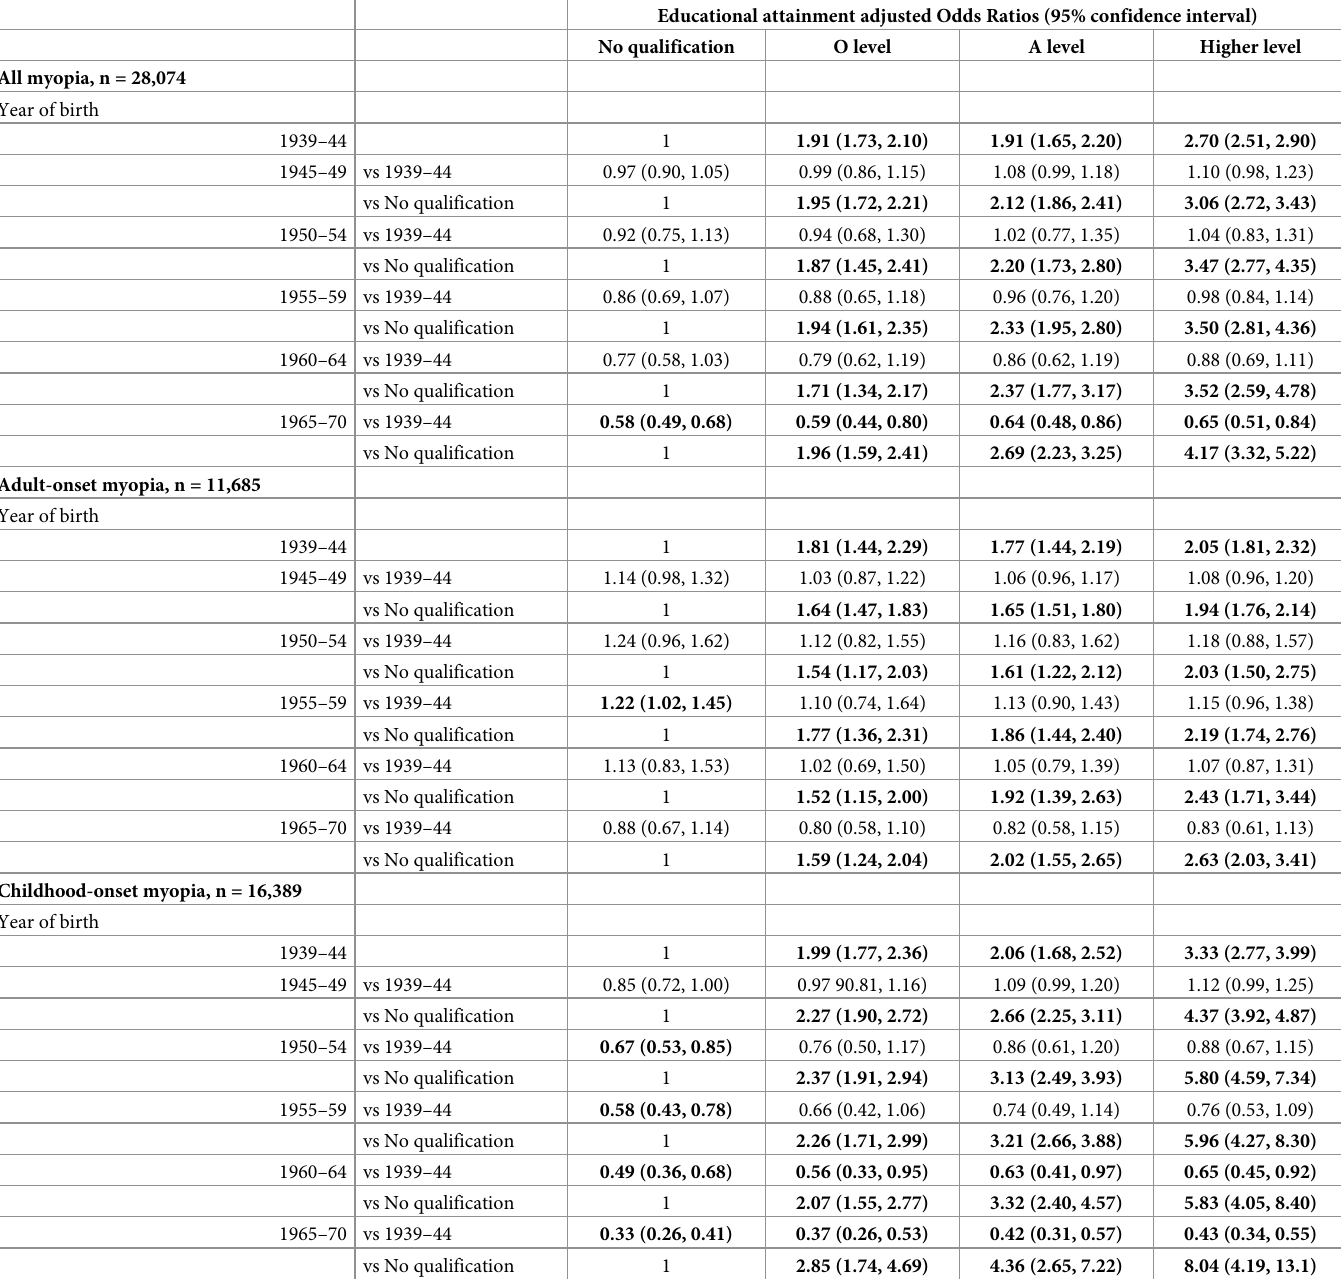
Table 3. Interactions in associations with myopia (all, childhood-onset and adult-onset) between year of birth and no educational